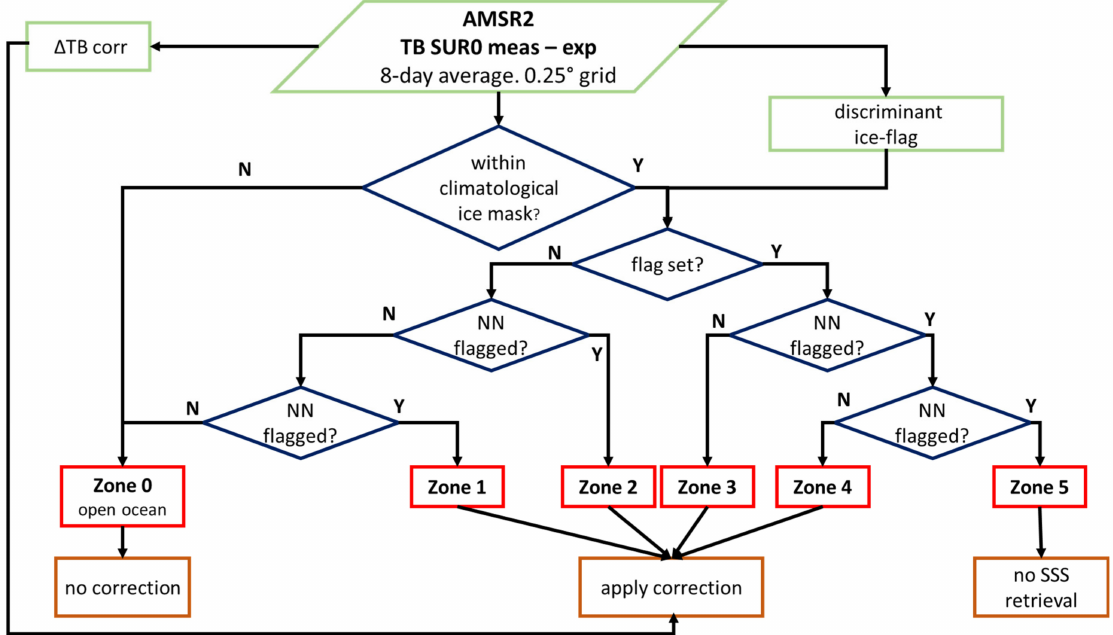
Figure 5. Schematic flow diagram of the sea-ice detection and flagging algorithm and defintion of the sea-ice zones